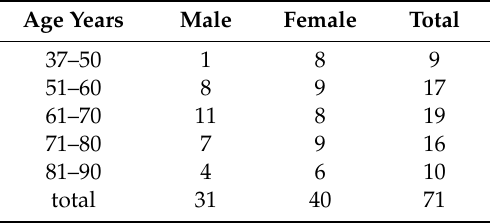
Table 3. The overall distribution by age at diagnosis and sex is as follows.